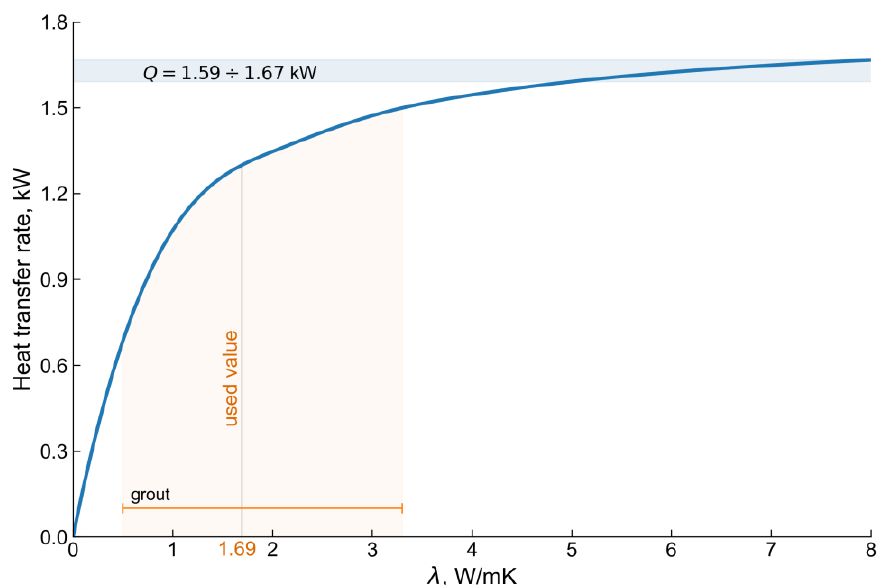
Figure 15. Dependence of the heat transfer rate on the grout thermal conductivity.